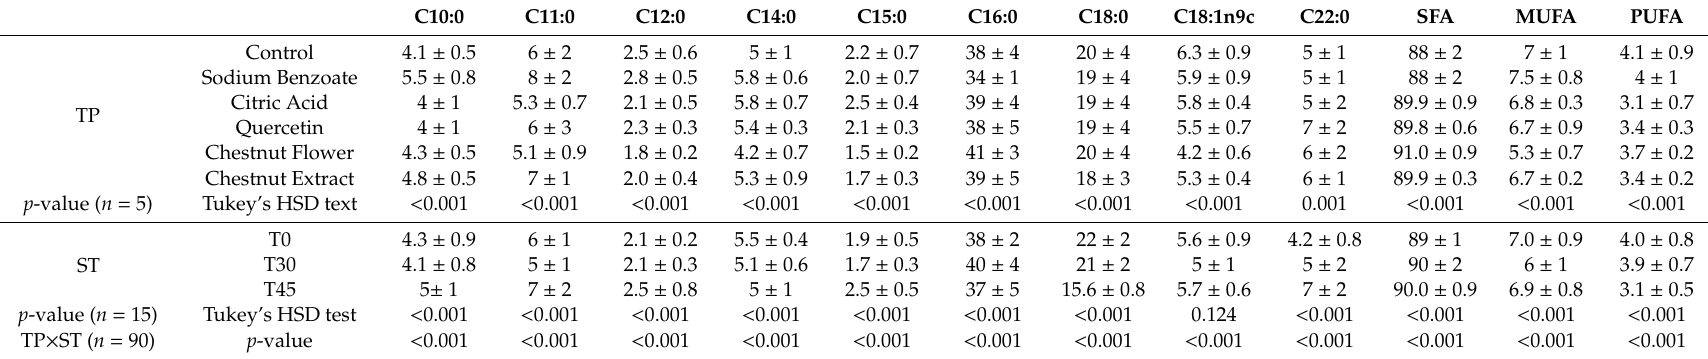
Table 2. Fatty acid profile of the di ff erent nutraceutical formulations, analyzed through gas chromatography, coupled to a flame ionization detector (GC-FID), expressed in relative